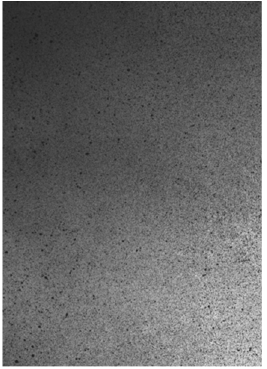
Figure 9. Speckle detail diagram.